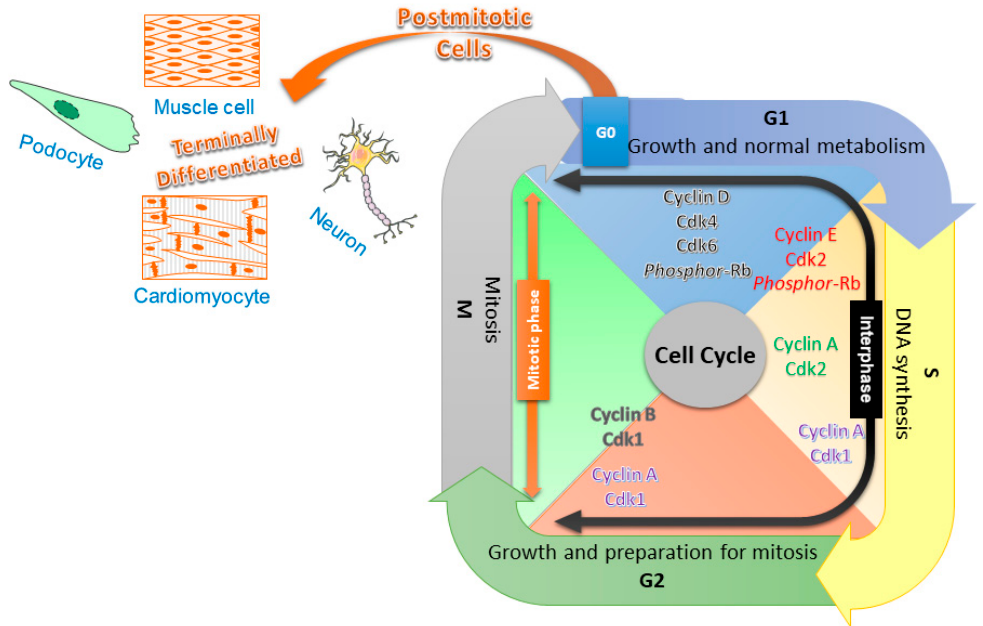
Figure 1. A simplified diagram illustrating the cell cycle progression and its regulators of various phases. The cell cycle is divided into the interphase and mitotic (M) phase; the former is further subdivided into three phases, namely G1, S, and G2. The di ff erentiated cells are without DNA replication and cellular division, remaining in the G0 stage. Upregulated cyclin D binds to and thereby activates Cdk4 and Cdk6 to phosphorylate the retinoblastoma (Rb) protein, allowing cells to escape from the quiescent state and start the G1 phase. The cyclin E-activated Cdk2 phosphorylates an additional Rb protein that promotes the progression of G1 into the S phase. The replication of DNA in the S phase is driven by cyclin A and Cdk2. The cyclin A / Cdk1 complex is found in both the late S and G2 phases, which is suggested to promote chromosome condensation. The formation of the cyclin B and Cdk1 complex regulates the G2 / M